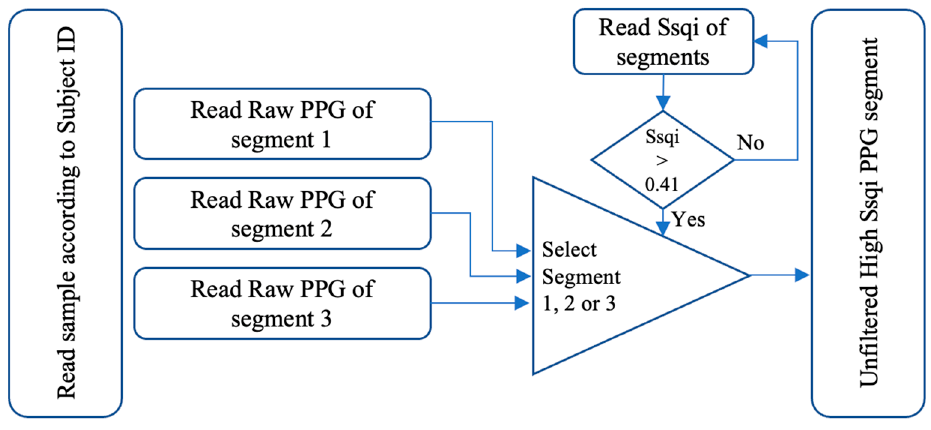
Figure 2. Data selection and preparation process.